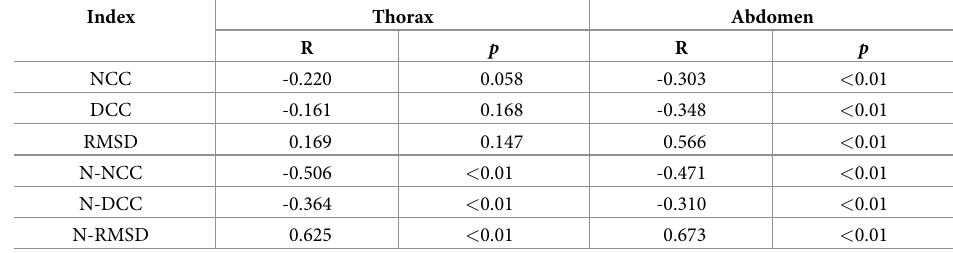
Table 4. Results of Pearson correlation analysis (R) for the RMA index and the visual standard of the operators who perform manual 4DCT sorting.